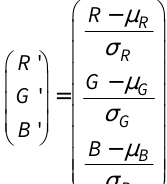
1 : Examples of histograms representing transformations from RGB to invariant colour